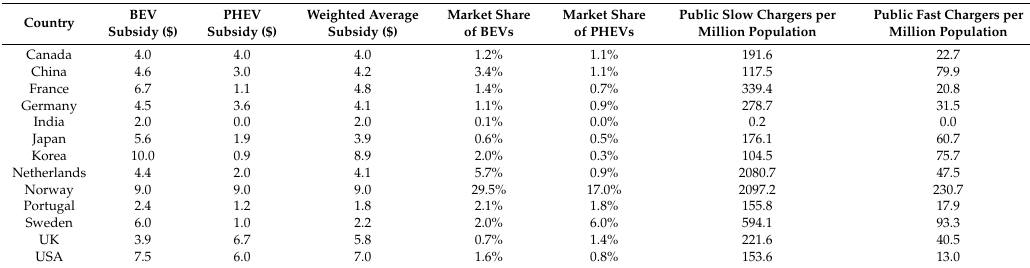
Table A4. Summary of numerical variables in